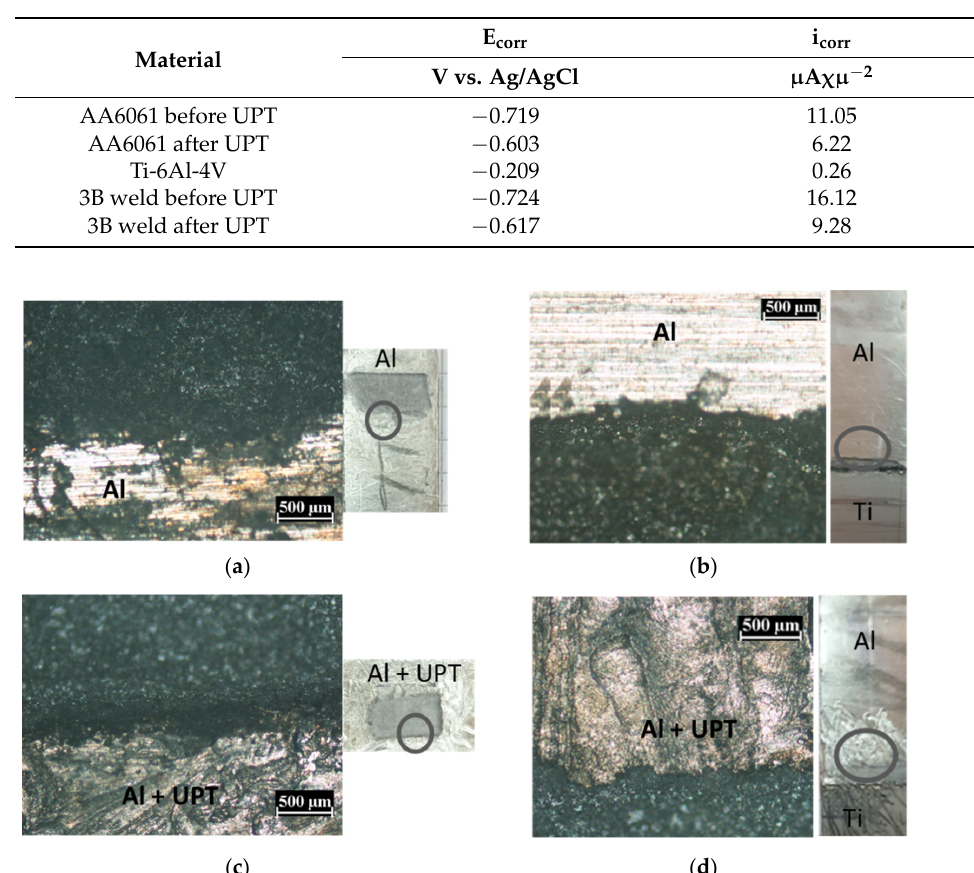
Figure 17. Pictures of corroded windows of the samples and optical micrographs of one edge of the corrosion window (circled in the pictures) for Al sample before UPT ( a ), Al sample after UPT ( c ), 3B weld before UPT ( b ) and 3B weld after UPT ( d ). Table 5. Corrosion potential and corrosion current density extracted from potentiodynamic polarization curves reported in Figure 16b.